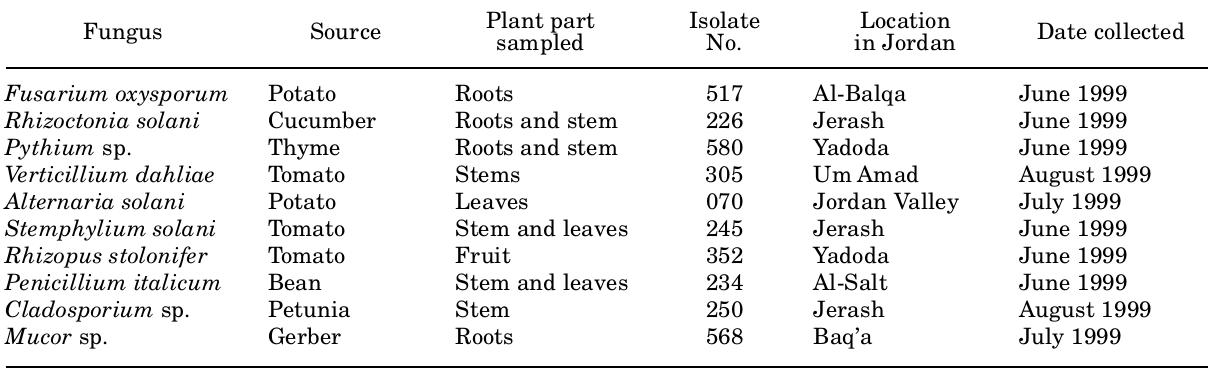
Table 1. Fungal isolates used to test the antifungal activity of extracts of Euphorbia macroclada . Fungus